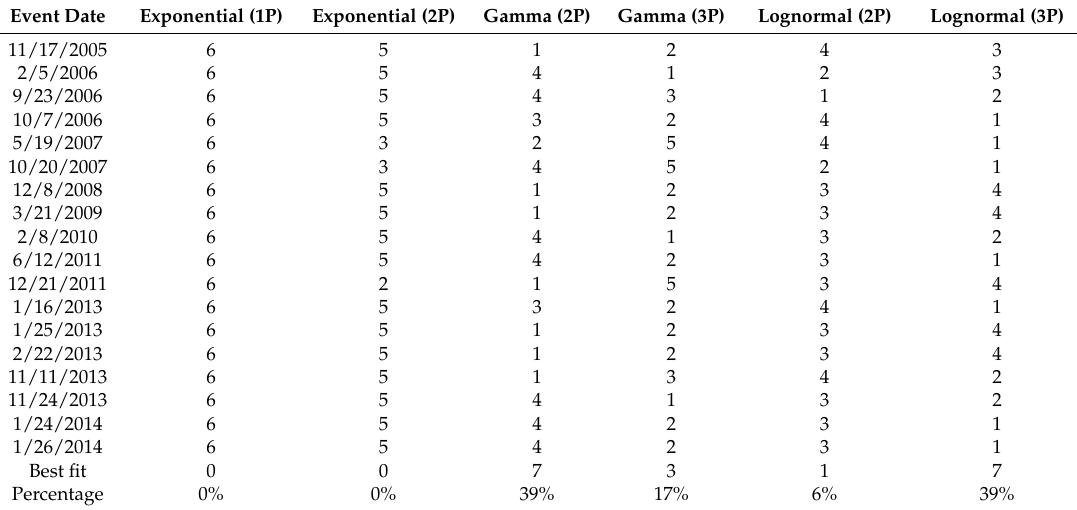
Table 4. Best fit for convective